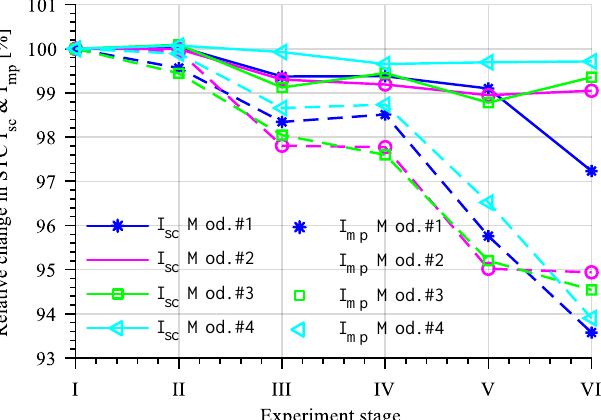
Figure 4. Relative change in the STC short-circuit and maximum power point currents of the four modules during the six stages of the experiment—described in Table 1.